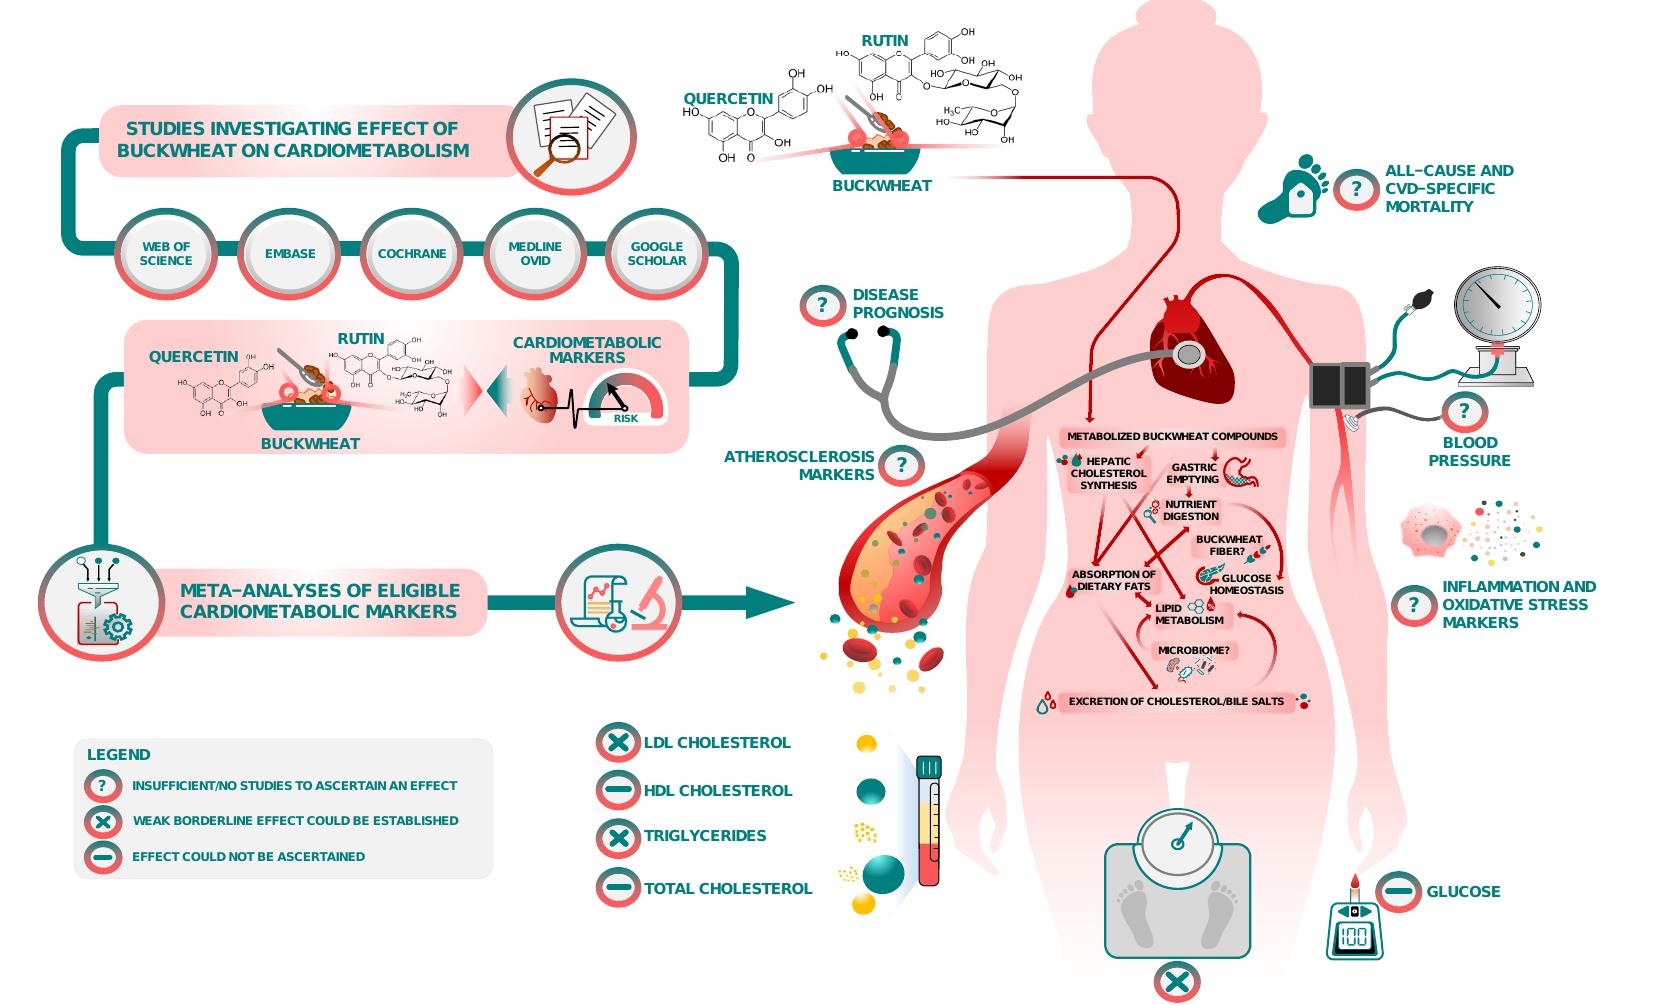
Figure 8. Visual summary, mechanisms and potential avenues for future research. Figure 8.